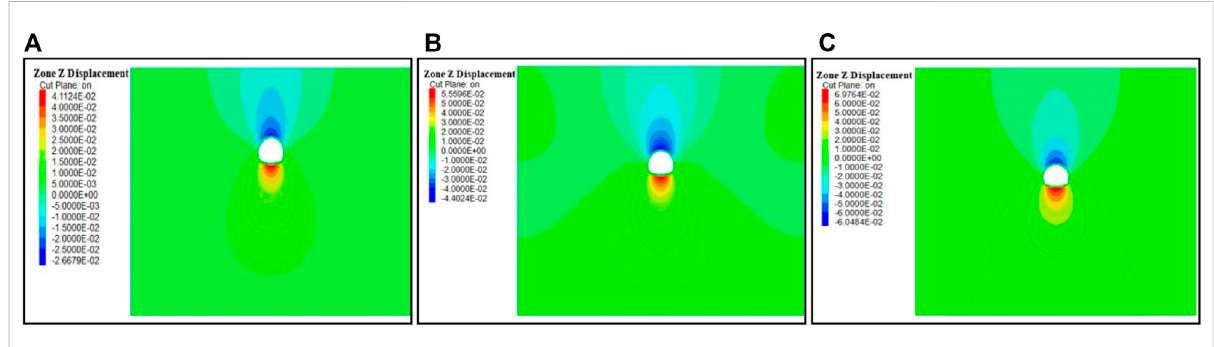
FIGURE 8 Verticaldisplacementcloudmapofdifferentburieddepths. (A) Verticaldisplacementcloudmapof30 mburieddepth; (B) verticaldisplacement cloud map of 40 m buried depth; and (C) vertical displacement cloud map of 50 m buried depth.